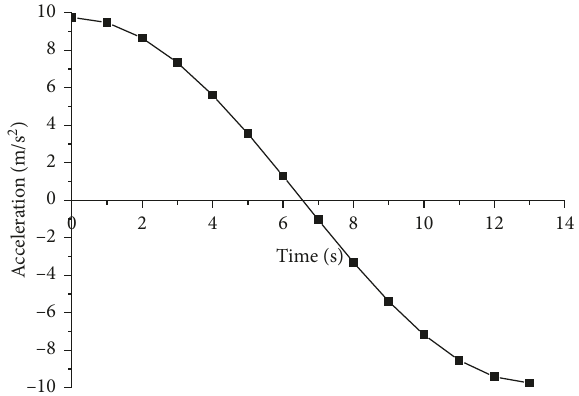
Figure 6: Changing curve of falling acceleration of sacked